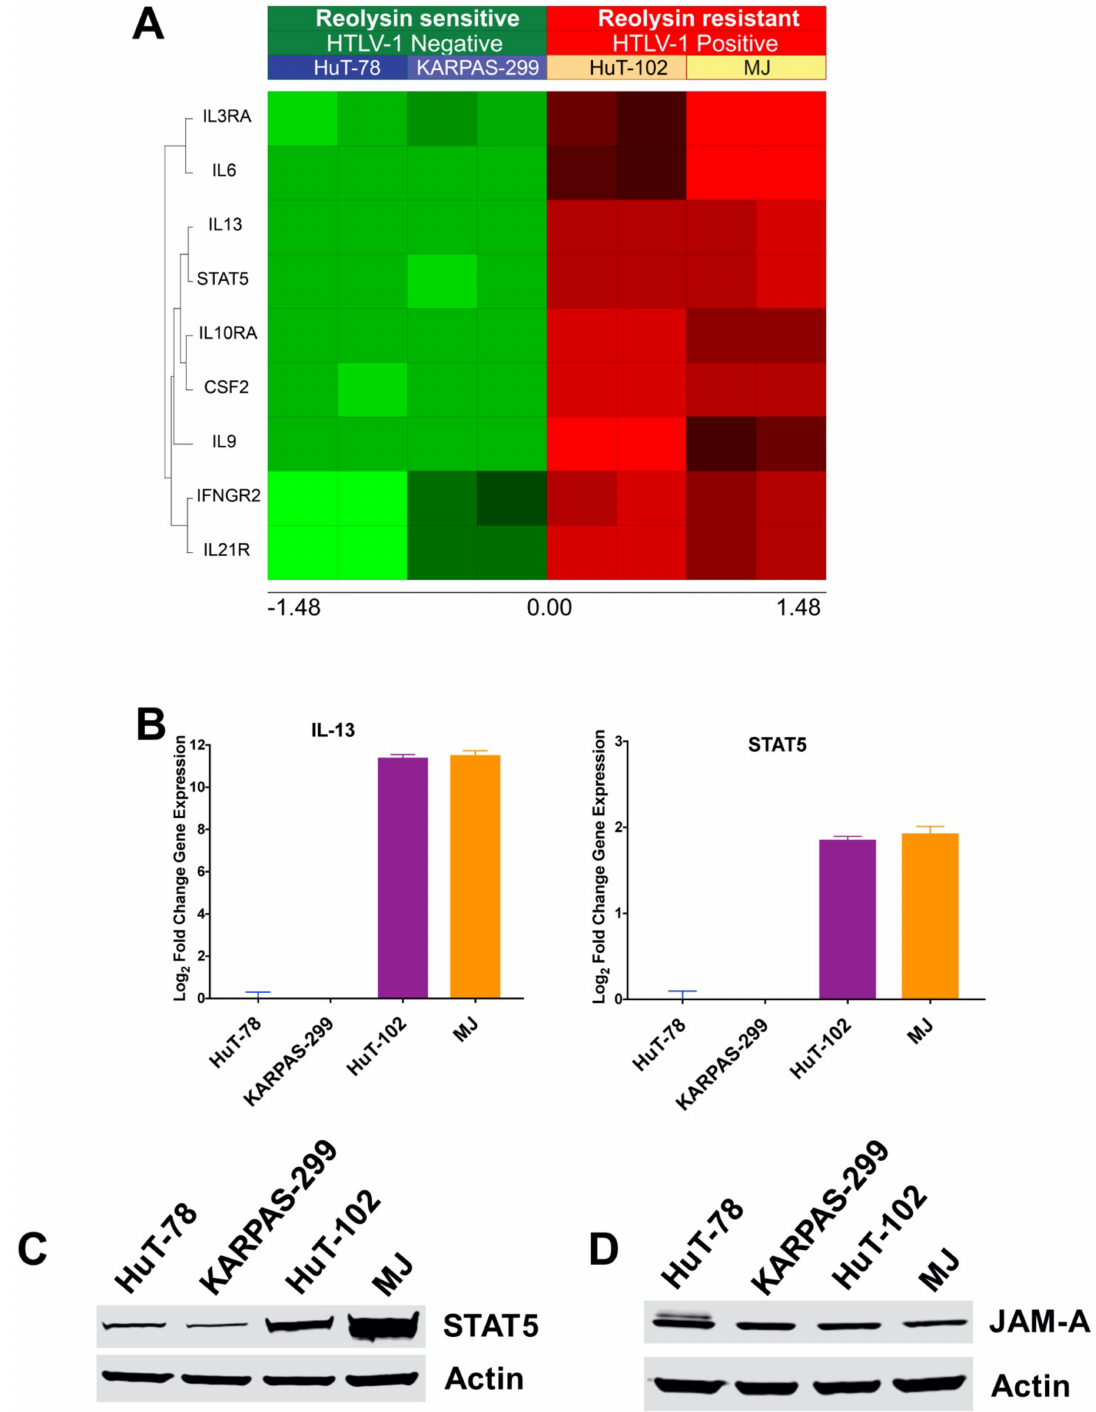
Figure 3. HTLV-1-positive TCL cells exhibit upregulated IL-13 and STAT5 expression. ( A ) Transcriptome analysis of HTLV-1-negative (HuT-78 and KARPAS-299) and HTLV-1-positive (HuT-102 and MJ) cell lines reveals significant alterations in JAK/STAT pathway-related genes including upregulation of IL-13 and STAT5. Gene expression changes were determined using Affymetrix expression arrays. Significantly upregulated genes are illustrated in the heatmap. ( B ) IL-13 and STAT5 levels are increased in HTLV-1-positive TCL cells. IL-13 and STAT5 expression was measured by quantitative real-time PCR in TCL cells. Mean ± SD, n = 3. ( C ) STAT5 expression is upregulated in HTLV-1-positive TCL cells. Immunoblotting determined that HuT-102 and MJ cells display increased expression of STAT5 compared to HTLV-1-negative TCL cells. ( D ) JAM-A expression is similar in 4 TCL cell lines. JAM-A levels were measured by